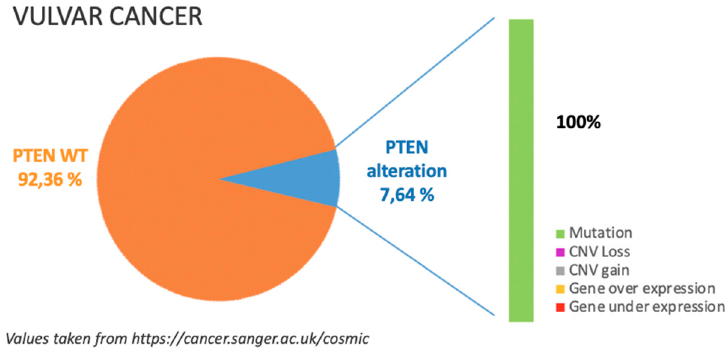
Figure 5. The incidence and type of PTEN alterations according to COSMIC dataset in vulvar cancer.